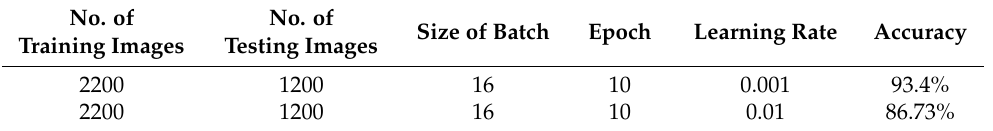
Table 6. Comparison between different learning rates.